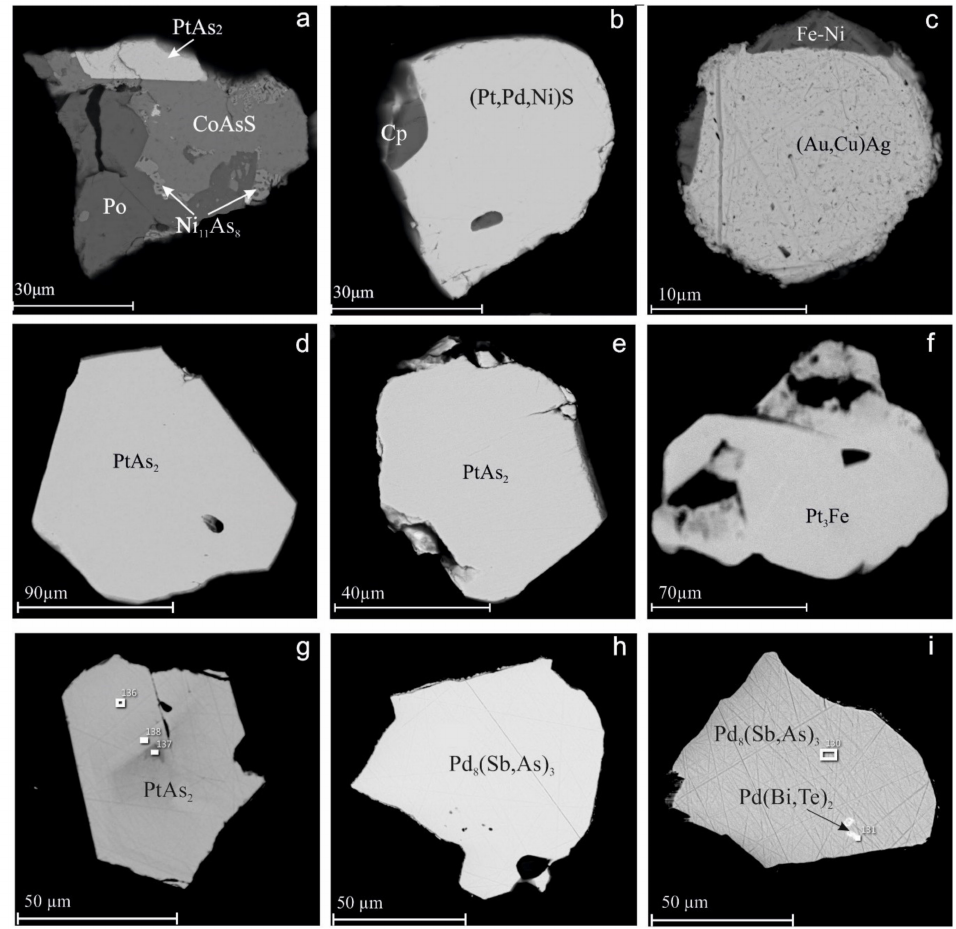
Figure 7. Minerals of precious metals from a heavy concentrate of crushing samples from the Oortsog ( a – c ) and Nomgon ( g – i ) massifs, and from the schlich samples of the Oortsog massif ( d – f ): ( a ) intergrowths of sperrylite with cobaltite (CoAsS), pyrrhotite (Po) and maucherite (Ni 11 As 8 ), ( b ) braggite Pt(S,Pd,Ni) with chalcopyrite (Cp), ( c ) Au-Ag alloy, ( d , e , g ) sperrylite crystals (PtAs 2 ), ( f )isoferroplatinumcrystal(Pt 3 Fe), ( h )grainofmertieite-II,( i )frooditeinclusionPd(Bi,Te) 2 inmertieite-II. Rectangles in images ( g – i ) areas of SEM